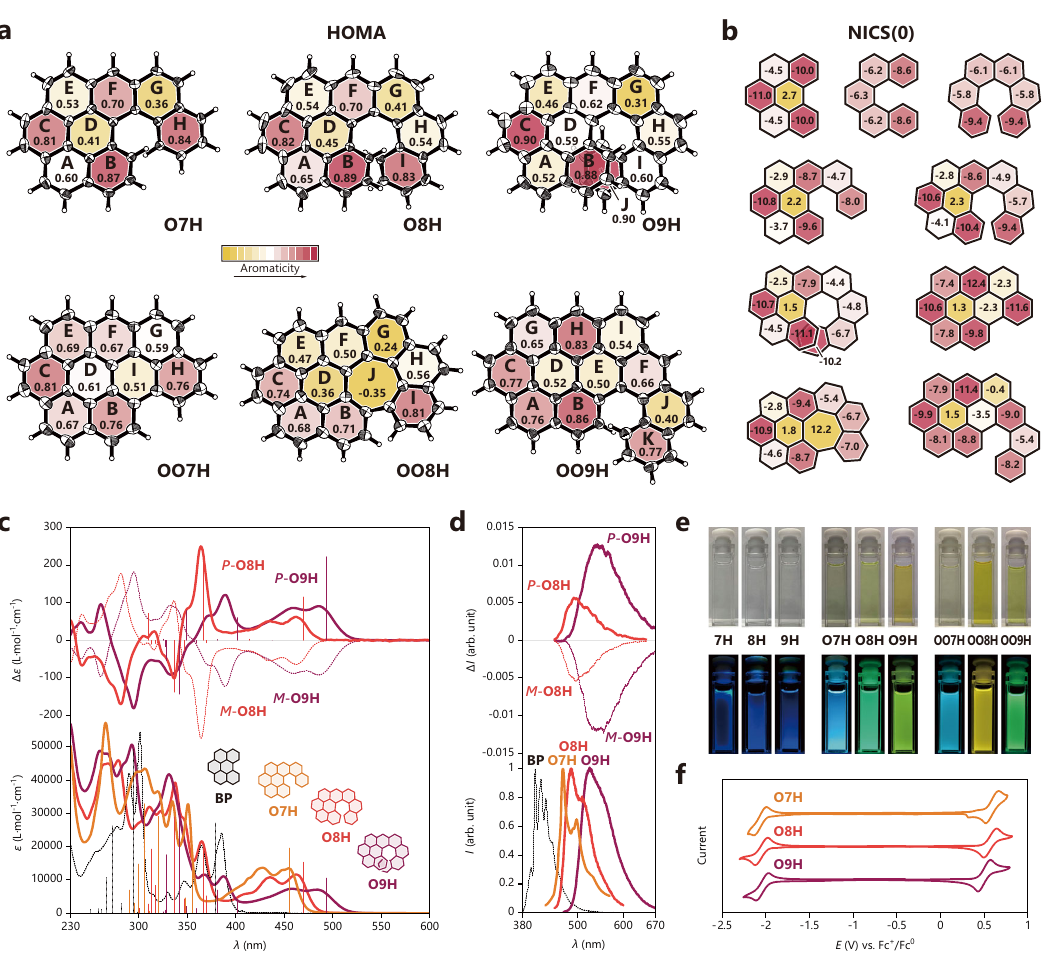
Fig. 4 Molecular properties of O7H, O8H, O9H, OO7H, OO8H, and OO9H. a , b Local aromaticity evaluation studied by harmonic oscillator model of aromaticity (HOMA) from the crystal structures (shown in thermal ellipsoid with a 30% probability) and nucleus-independent chemical shifts, NICS (0) from theoretical calculations. c UV-vis absorption (bottom) and electronic circular dichroism (ECD) (top) spectra of benzo[ ghi ]perylene (BP), O7H , O8H , and O9H (in CH 2 Cl 2 , c = 2.0 × 10 − 5 mol L − 1 ). Calculated excitation energies and oscillator/rotatory strengths (velocity form) are displayed as sticks (the fi rst 10 excitations). d Fluorescence (bottom) and circularly polarized luminescence (CPL) (top) spectra of benzo[ ghi ]perylene, O7H , O8H , and O9H (in CH 2 Cl 2 , c = 2.0 × 10 − 5 mol L − 1 ). e Photographs of corresponding solutions in CH 2 Cl 2 recorded under ambient light (top) and irradiation at 365 nm (bottom). f Cyclic voltammograms for O7H , O8H , and O9H (in CH 2 Cl 2 , containing 0.2 mol L − 1 of n -Bu 4 NPF 6 , scan rate = 0.1 mV s − 1